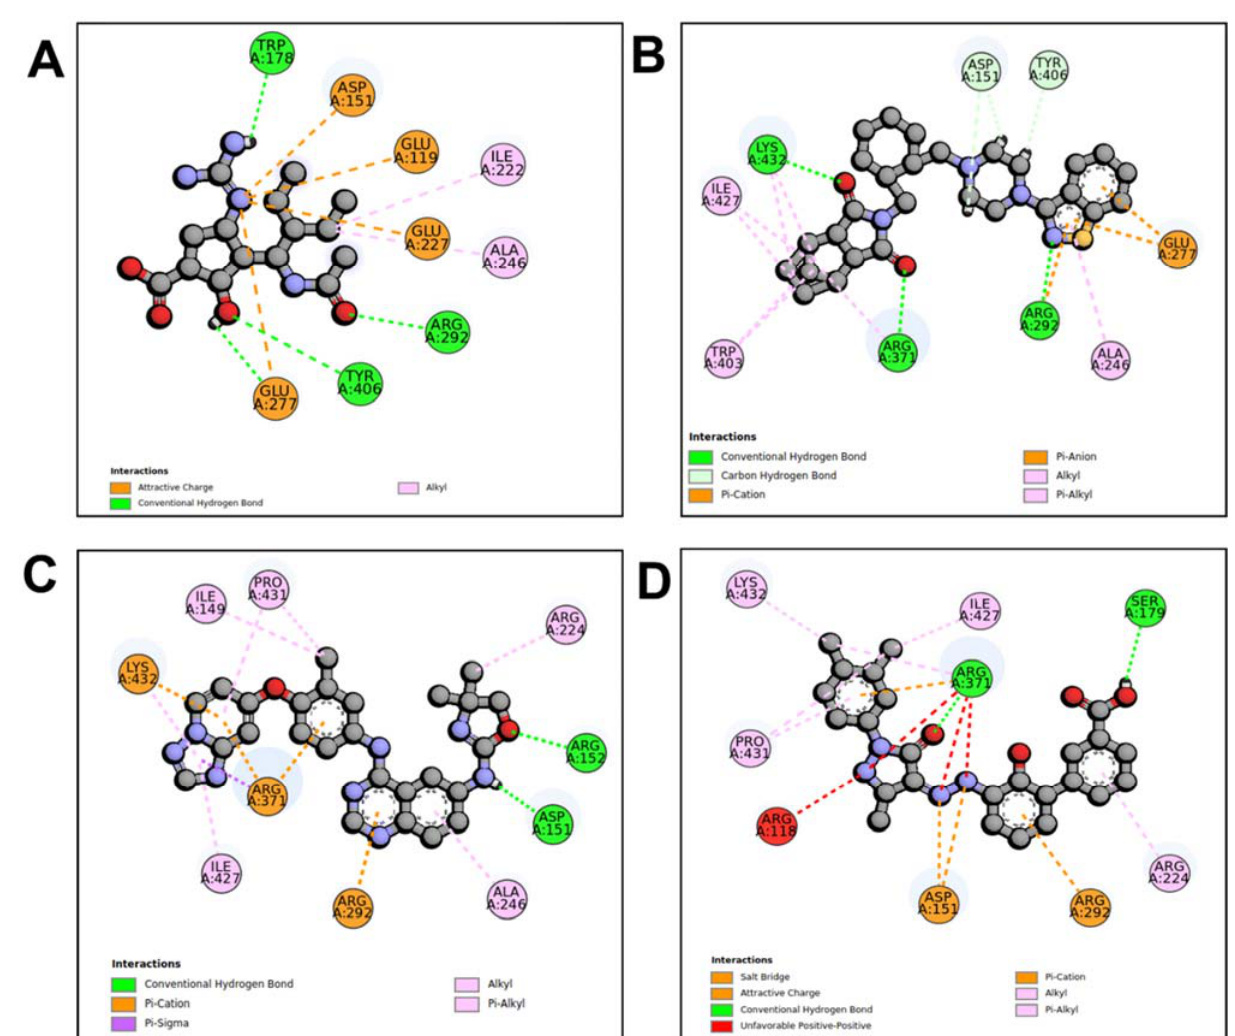
Figure 3. Molecular interaction profiles of NA with peramivir ( A ), lurasidone ( B ), tucatinib ( C ), and Promacta ( D ) .